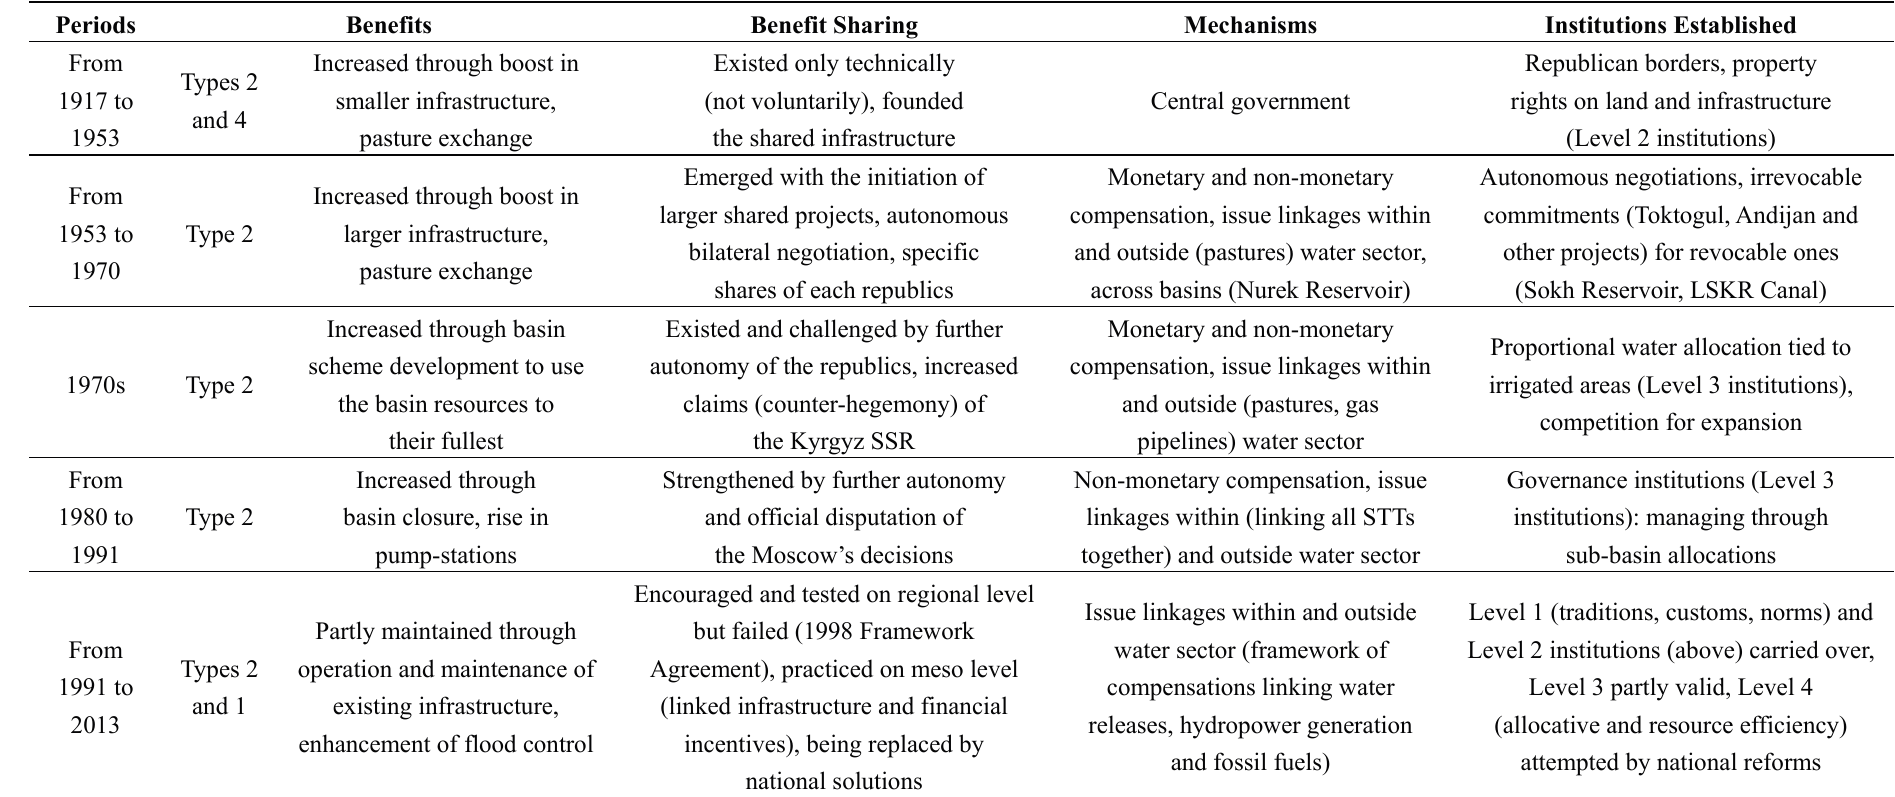
Table 3. Summary of the